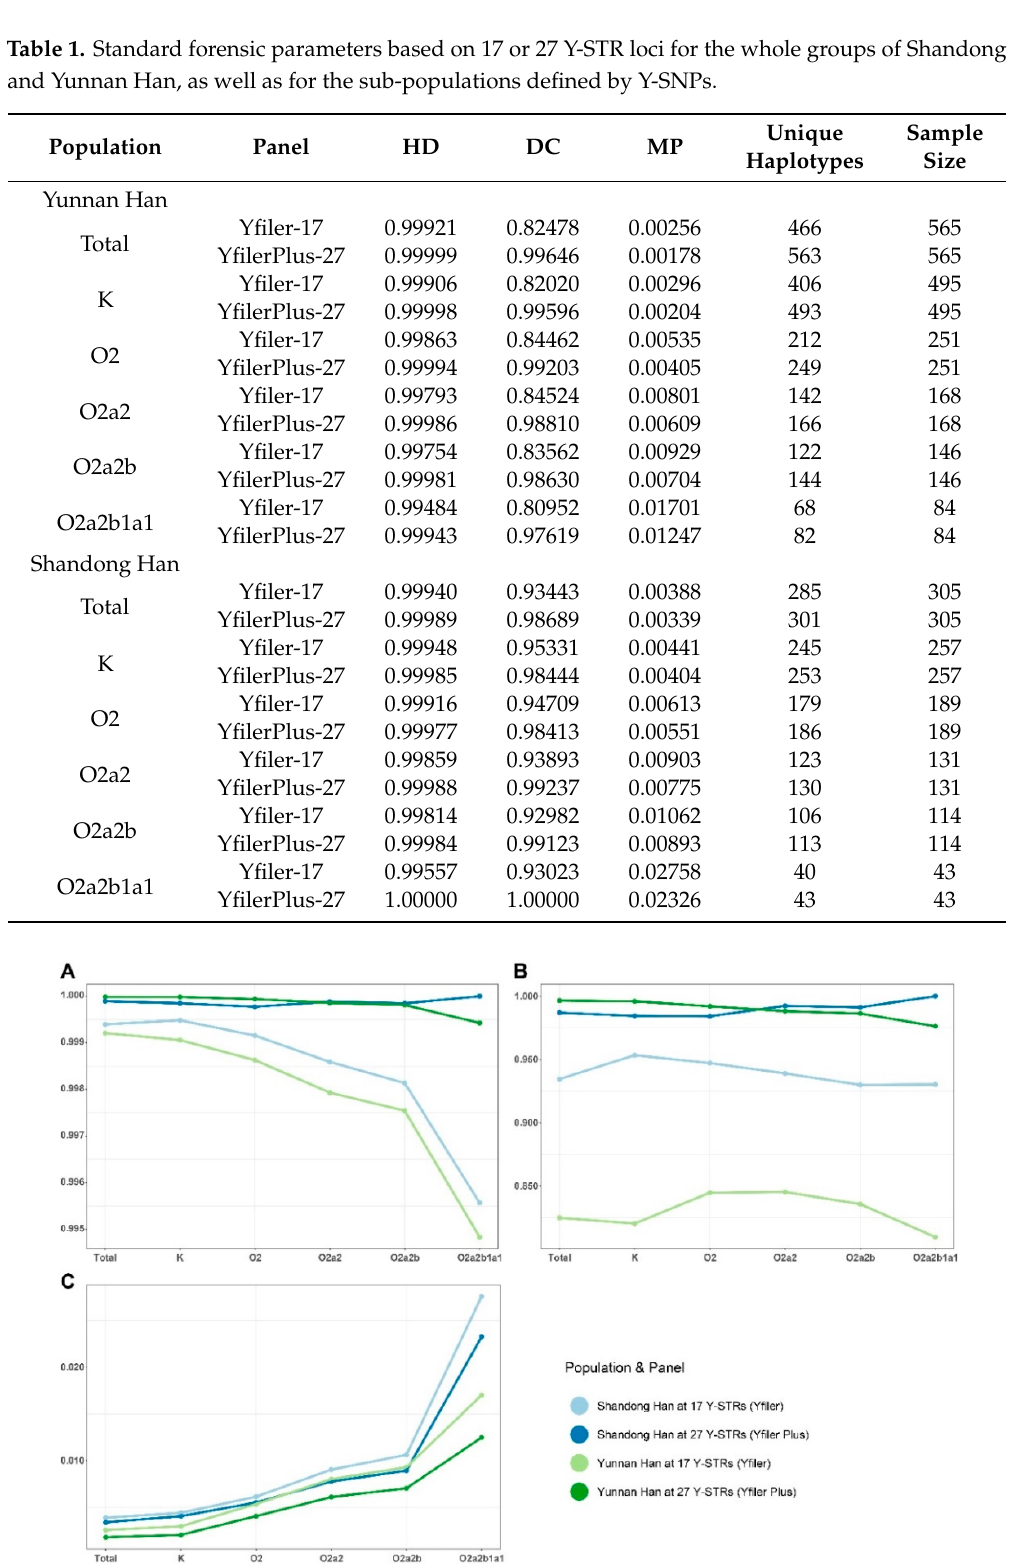
Figure 6. Varying patterns of haplotype diversity (HD), discrimination capacity (DC), and match probability (MP), calculated for different Y-STR panels, in the whole groups of Shandong and Yunnan Han as well as in the sub-populations defined by Y-SNPs. ( A ) HD values. ( B ) DC values. ( C ) MP values. Different colors denote different populations for the 17- or 27-Y-STR panel.